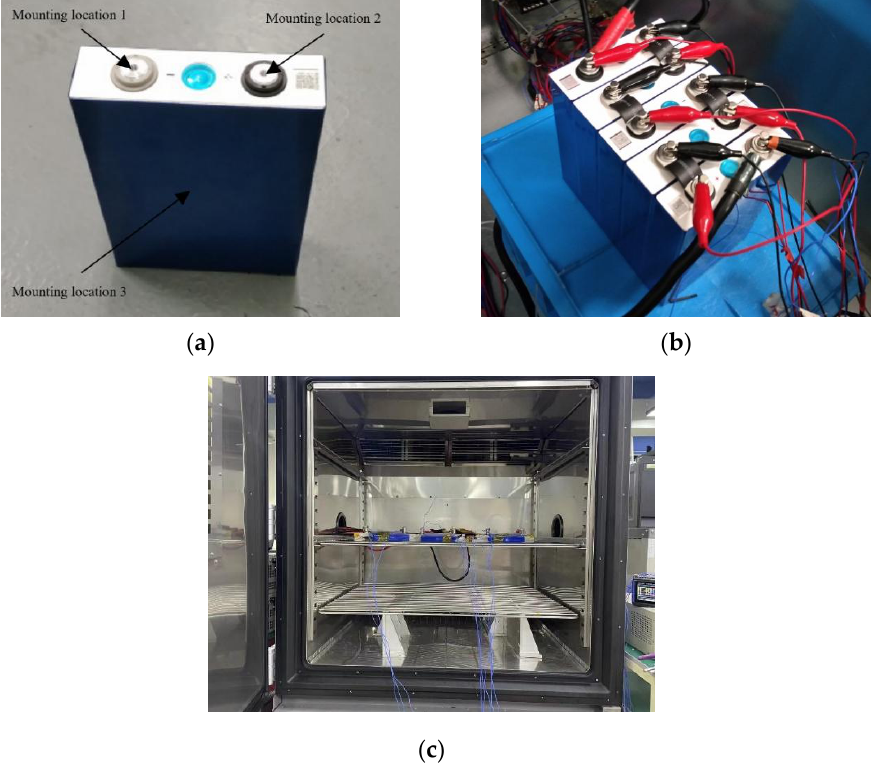
Figure 3. ( a ) The experimental subject LF105 battery. ( b ) The batteries in experiment. ( c ) The thermostat used in the experiment.